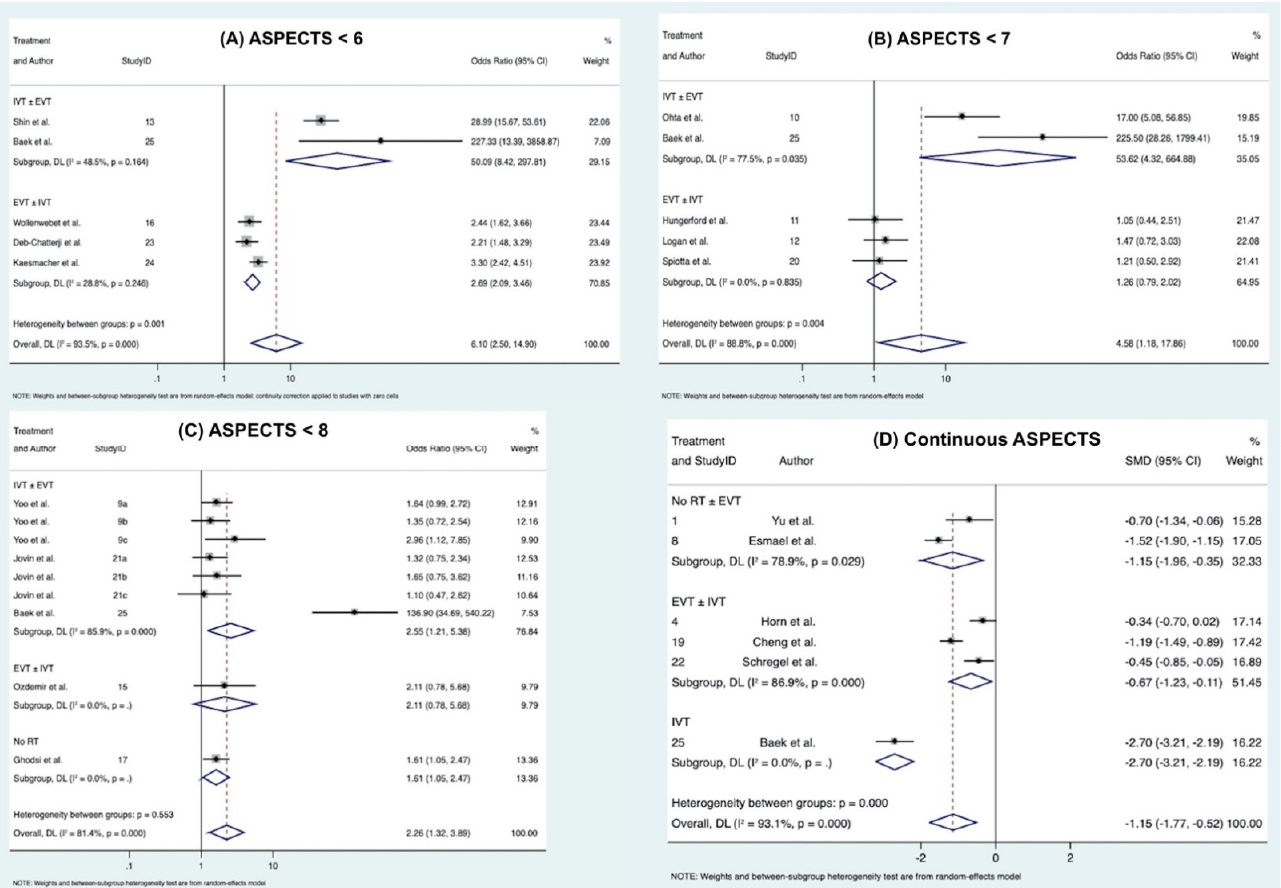
Figure 3. Forest plot of estimated effect for the association of: ( A ) ASPECTS < 6 [27,30,36–38], ( B ) AS- PECTS < 7 [24–26,34,38], ( C ) ASPECTS < 8 [6,23,29,31,38] and ( D ) continuous ASPECTS